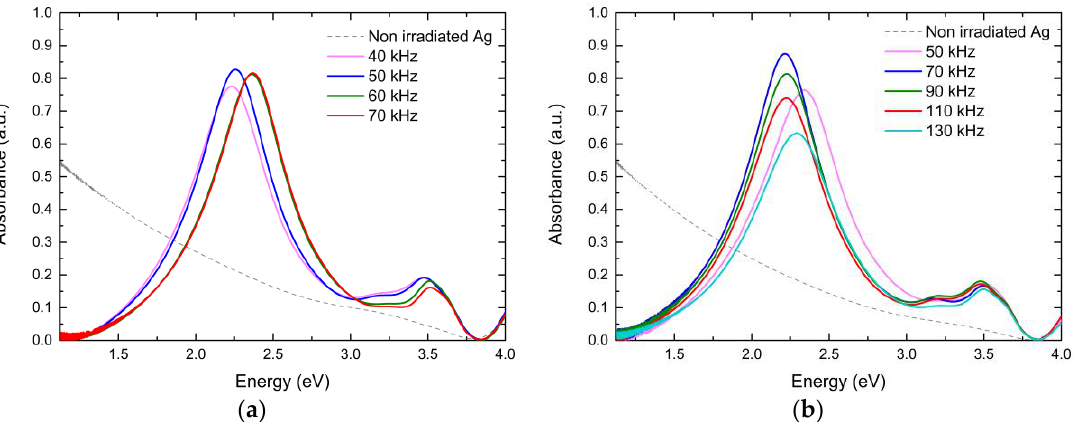
Figure 5. Absorbance spectra for areas of two 12.5 nm Ag films, Ag #2 ( a ) and Ag #3 ( b ), irradiated with various laser frequency values.